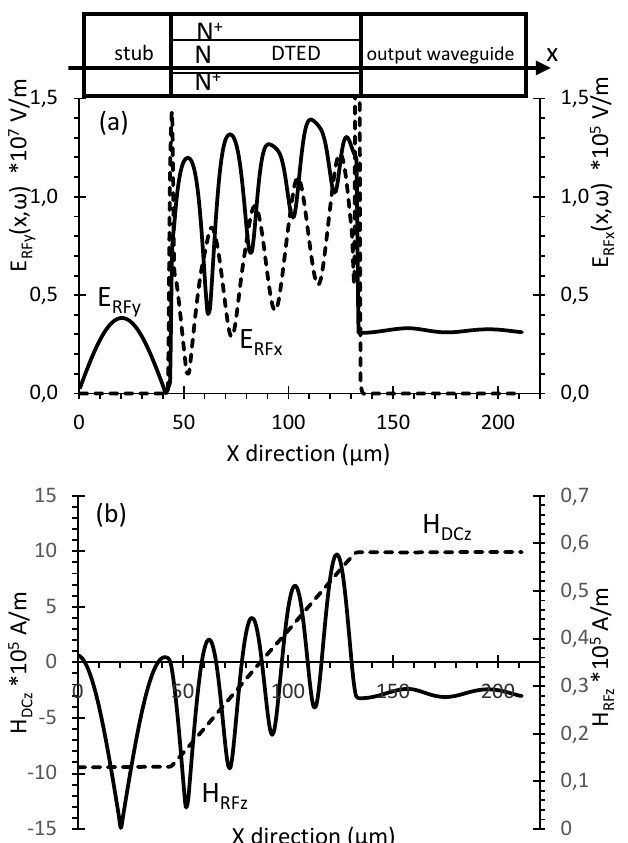
Figure 6: Spatial evolutions of the magnitude of the x direction EM field components at the fundamental frequency at y=0,35 µm